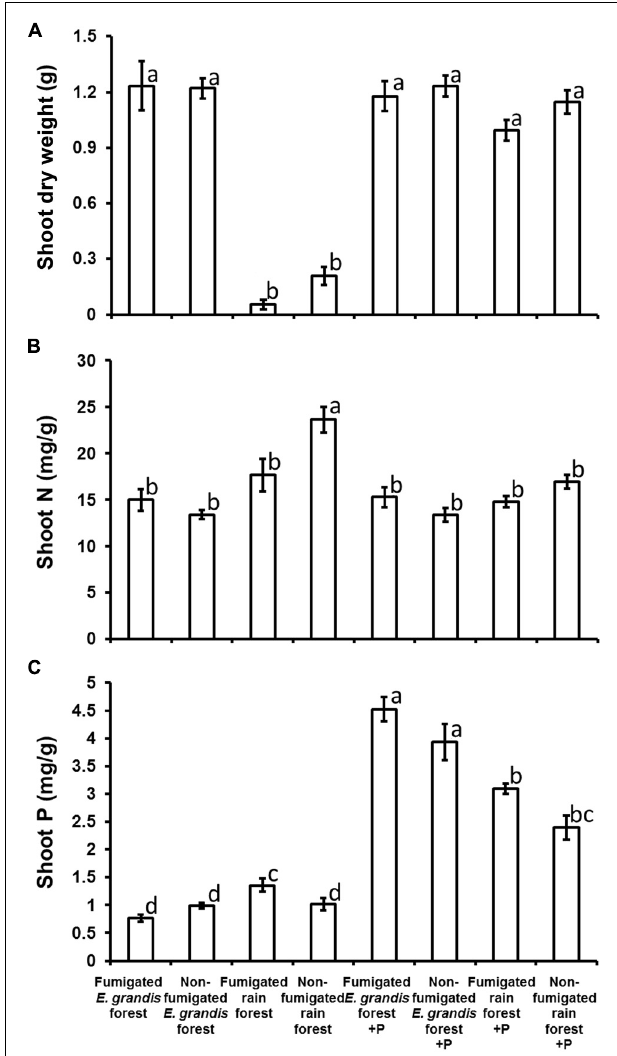
FIGURE 5 | Soil type ( E. grandis forest versus rain forest), fumigation, and P addition ( + P) effects on Eucalyptus grandis seedling (mean ± SE) shoot dry weight (g;A), shoot nitrogen concentration (mg/g; B), and shoot phosphorus concentration (mg/g; C) at harvest, 146 days after transplant (DAT). Bars topped by the same lowercase letter do not differ significantly at P ≤ 0.05 byTukey’s honestly significant difference post hoc test.The numbers of surviving replicates at 146 DAT were: non-fumigated E. grandis ( n = 26 no P added, 25 P added), Fumigated E. grandis ( n = 27 no P added, 29 P added), Non-fumigated rain forest ( n = 16 no P added, 22 P added) and Fumigated rain forest ( n = 20 no P added, 28 P added).Thirteen seedlings which were diseased at 146 DAT were excluded.